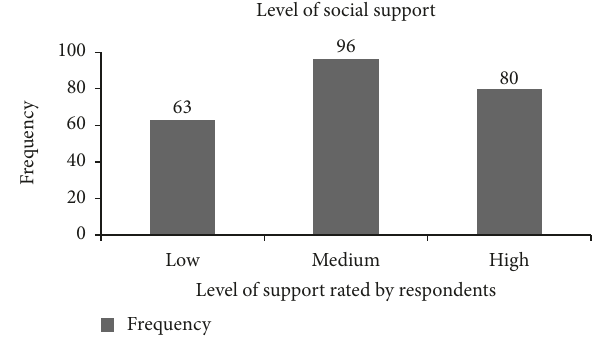
Figure 1: Frequency of level of social support of respondents on depression and associated factors among adult inpatients in Harari region hospitals, Eastern Ethiopia, 2017 ( 𝑛 = 239 ).